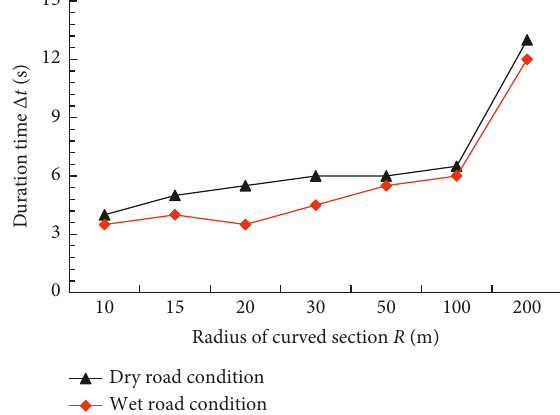
Figure 21: The duration time of “curve balance state” with different